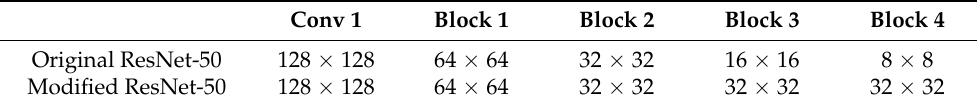
Table 1. Comparison of the spatial resolution of the output feature map of ResNet50 before and after modification. Conv 1 Block 1 Block 2 Block 3 Block 4 Original ResNet-50 128 × 128 64 × 64 32 × 32 16 × 16 8 × 8 Modified ResNet-50 128 × 128 64 × 64 32 × 32 32 × 32 32 ×